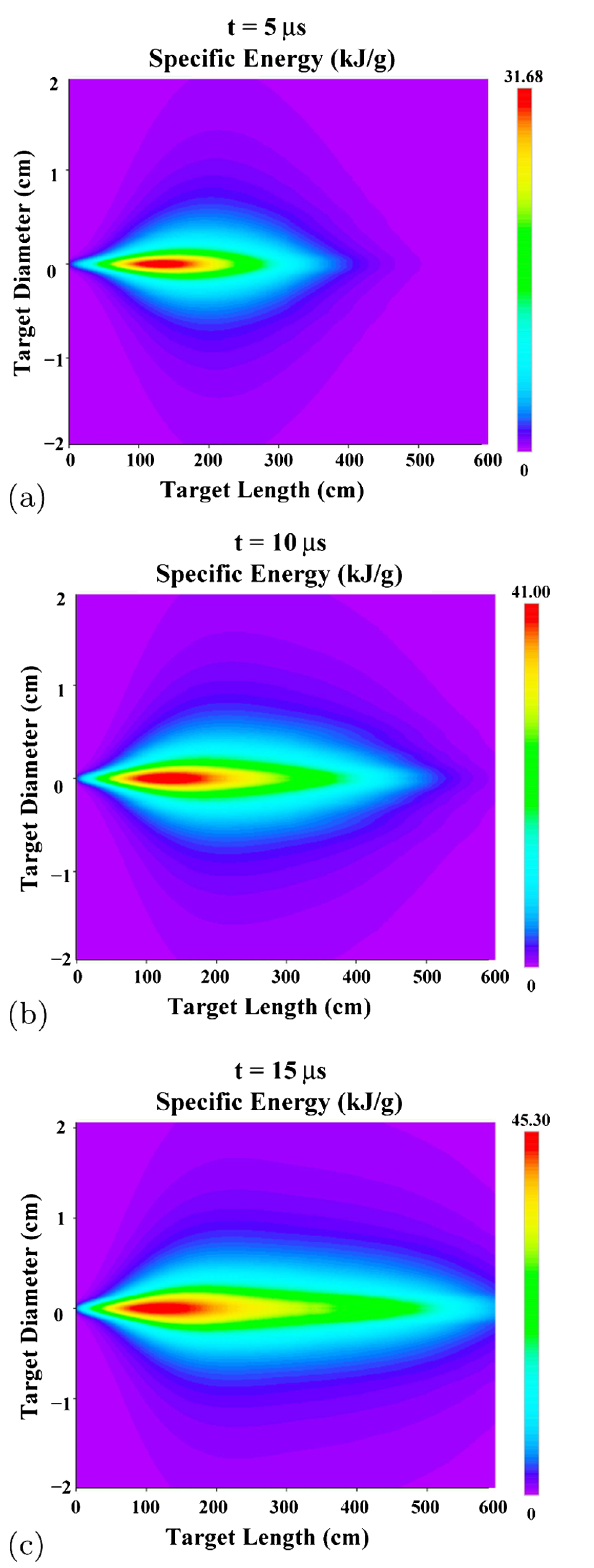
FIG. 4. Specific energy deposition distribution calculated by BIG2 in the carbon cylinder, r ¼ 5 cm , L ¼ 6 m , irradiated by the LHC beam at the left face; (a) at t ¼ 5 (cid:2) s ; (b) at t ¼ 10 (cid:2) s ; and (c) at t ¼ 15 (cid:2) s .